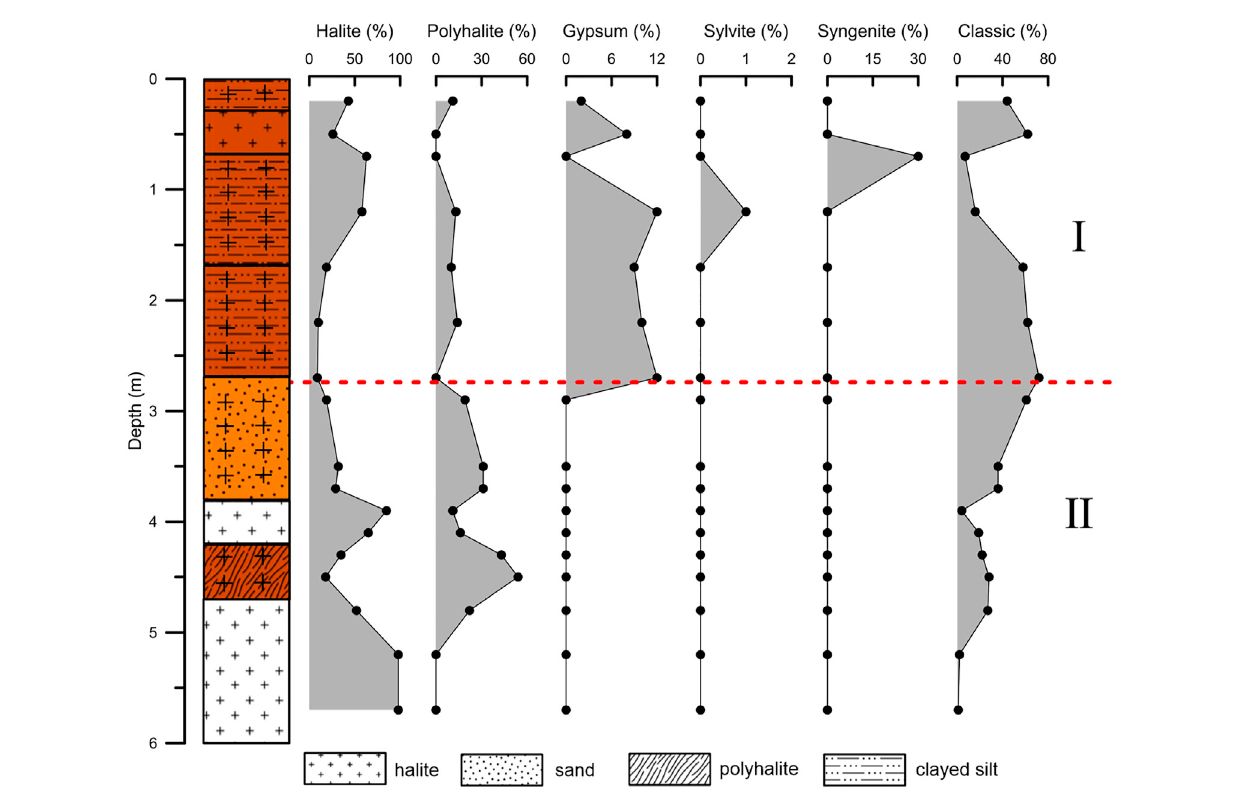
FIGURE 7 | Changes in main minerals with depth in section. The upper part ( Ⅰ ) is characterized by polyhalite coexisting with gypsum, and the lower part (II) is characterized by polyhalite coexisting without gypsum.